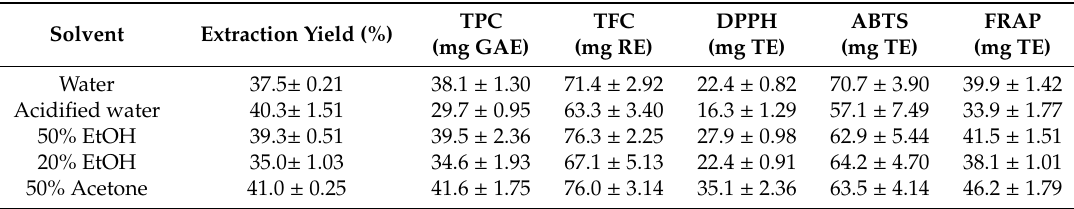
Table 2. Extraction yield and antioxidant capacity indicators (expressed per gram of EOP) at 55 ◦ C for 90 min and 15%